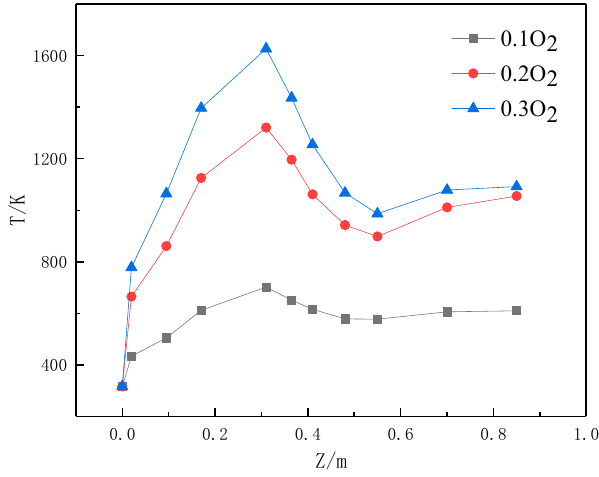
Figure 8. Temperature curves with respect to the O 2 ratio.